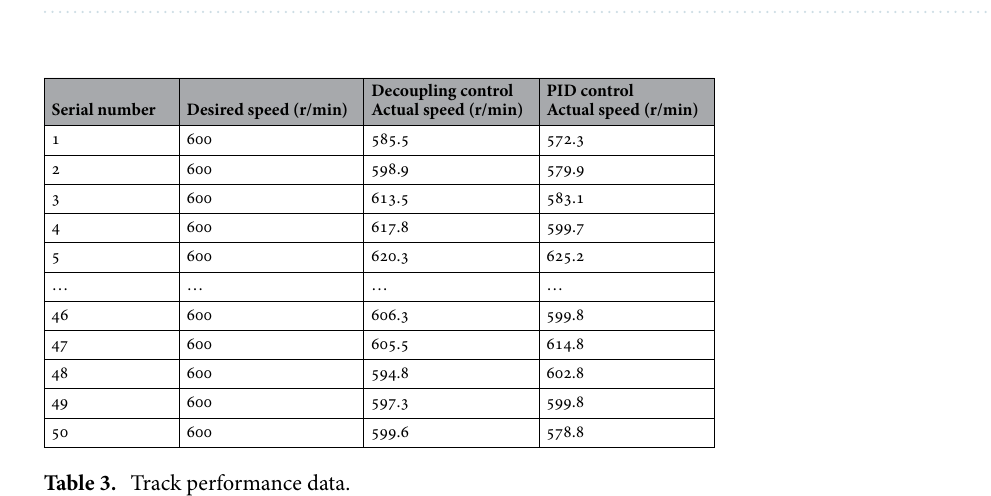
Figure 11. Speed deviation contrast curve.